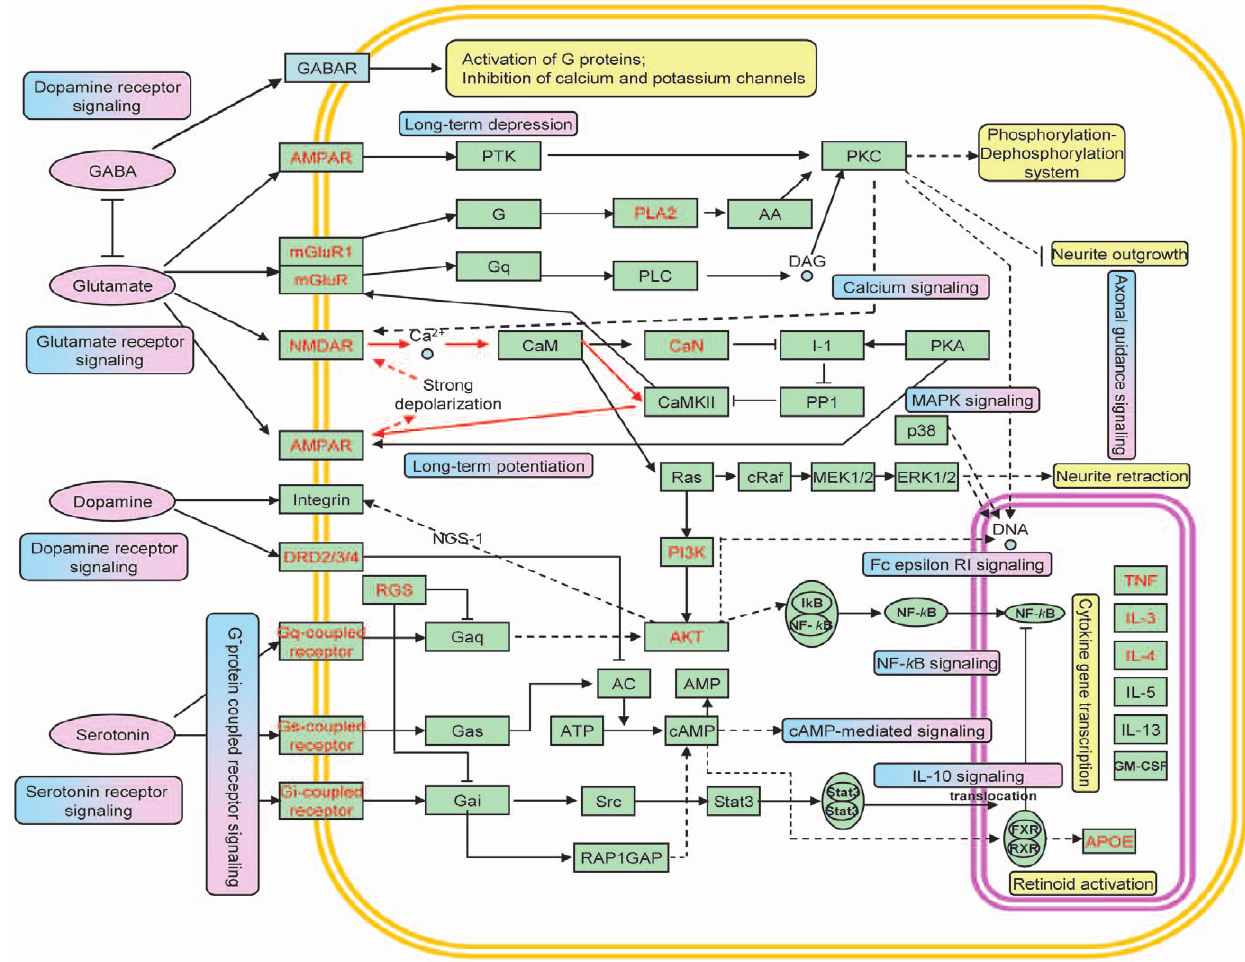
Figure 4. Schizophrenia molecular network (SMN). This network was constructed by using schizophrenia related pathways, protein-protein interactions and literature survey. SZGenes are in red text and neurotransmitters in pink background. The enriched pathways are highlighted in the boxes with a blue and pink background. Several feedback loops are identified including those highlighted with red lines.